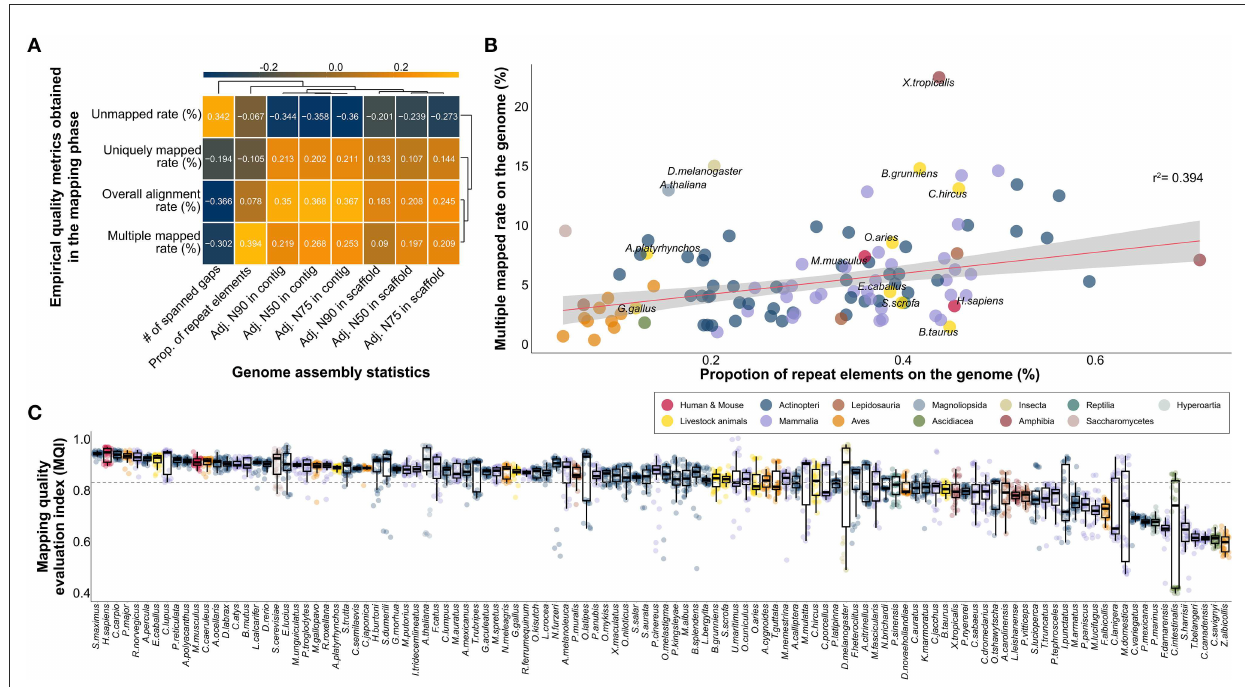
FIGURE3 Investigation of association relationship between assembly statistics and empirical effective indicators obtained in the mapping step for genome quality evaluation. (A) Pairwise correlation between selected assembly statistics and empirical effective indicators obtained in the mapping step for genome quality assessment. (B) Linear relationship between the ratio of multiple mapped reads and proportion of repeat elements on the genome in 108 species. r 2 represents correlation coefficient, respectively. (C) Differences in newly proposed MQI values in 108 species. To evaluate the relative quality of the genome, valid empirical indicators were integrated and configured in the mapping stage. The horizontal line represents the average MQI value across all 108